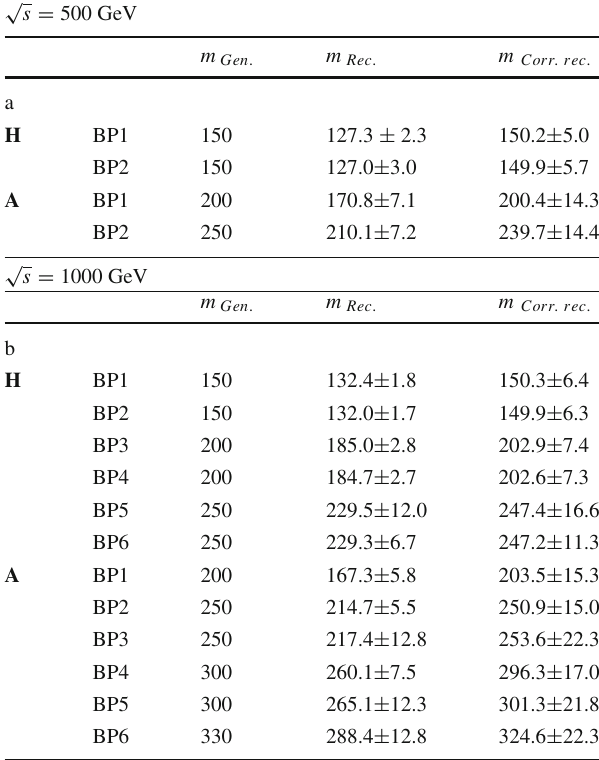
Table 7 Generated mass ( m Gen . ), reconstructed mass ( m Rec . ) and cor- rected reconstructed mass ( m Corr . rec . ) of the Higgs bosons H and A √ s = (a) 500 and (b) 1000 GeV. The with associated uncertainties at mass values are provided in GeV unit